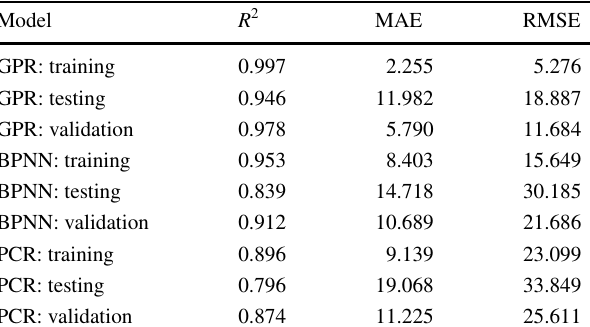
Table 3 Performance indices in training, testing and validation stages Model